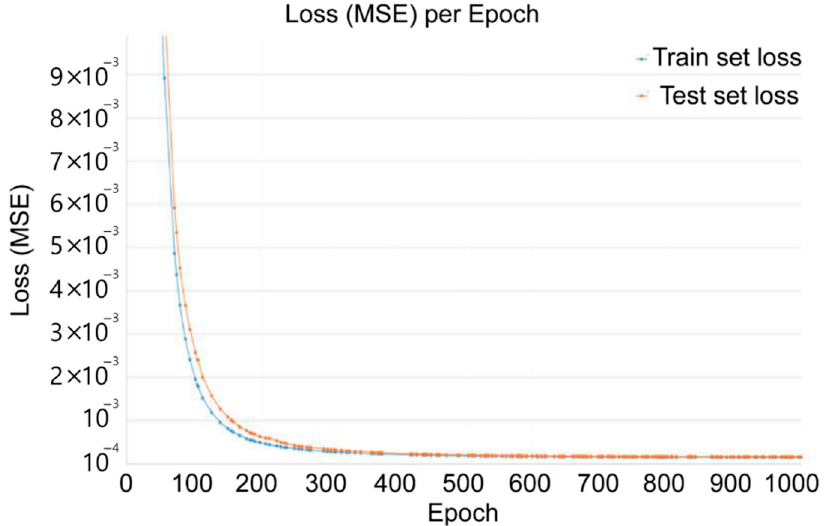
Figure 10. MSE of consequence prediction data.